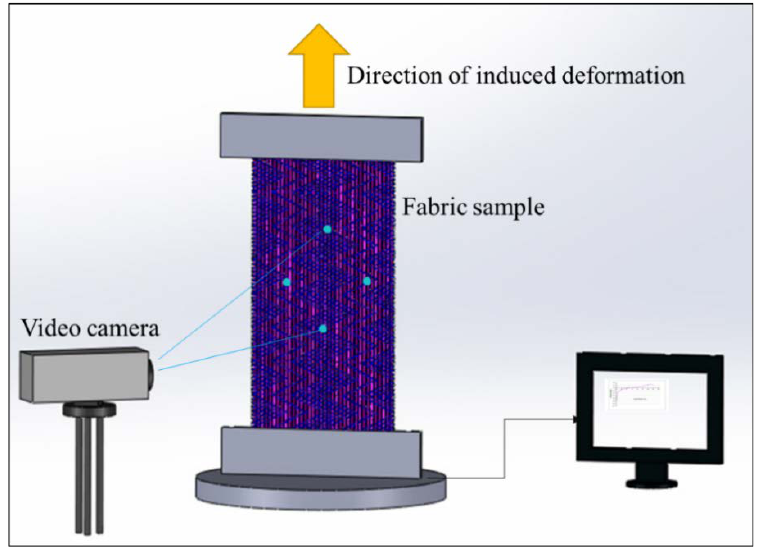
Figure 7. Experimental setup to determine Poisson’s ratio.